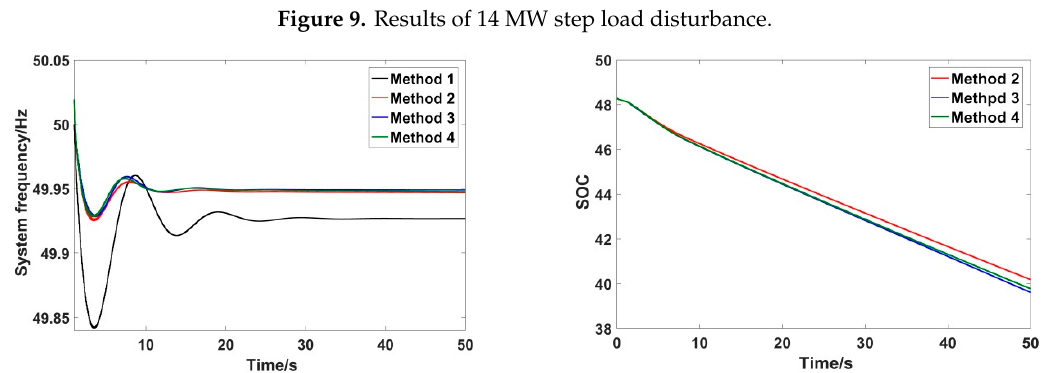
Figure 10. Results of 15 MW step load disturbance.